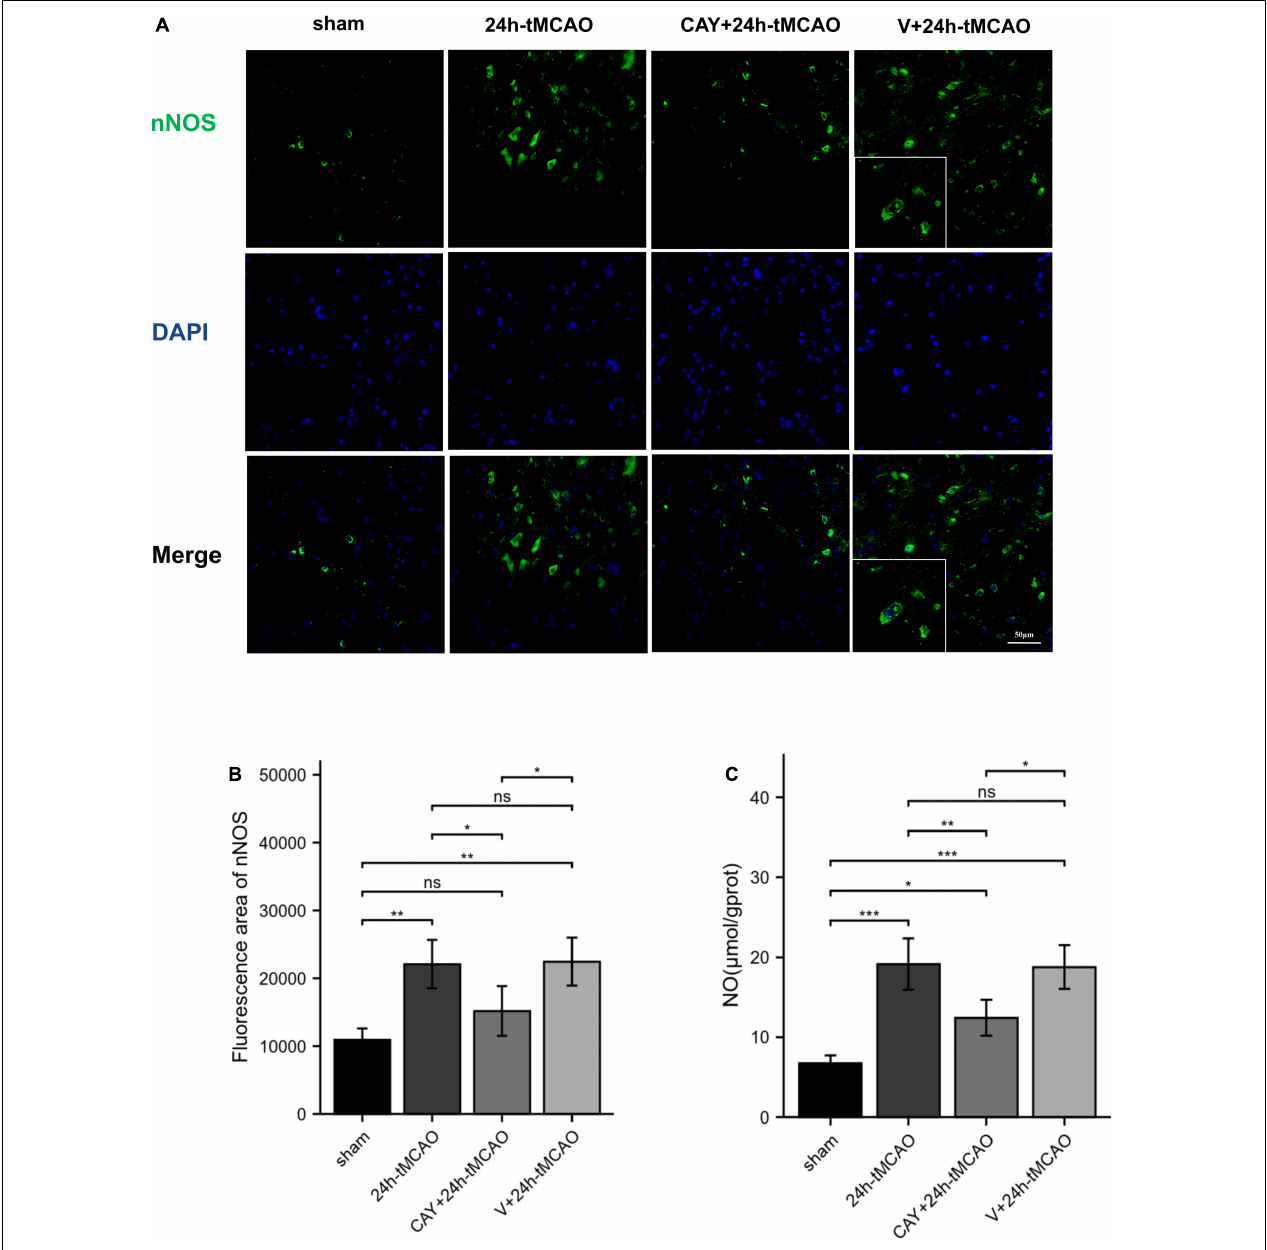
FIGURE 5 | nNOS fluorescence image and NO content expression. (A,B) DAPI (blue)/nNOS (green) Representative immunofluorescence images and statistical results of mouse brain tissue slices after tMCAO. (C) NO production was measured ( n = 4). Data are presented as the mean ± SEM. P -values were determined by ANOVA followed by the Tukey post hoc test, * P < 0.05; ** P < 0.01; *** P < 0.001; and ns, not